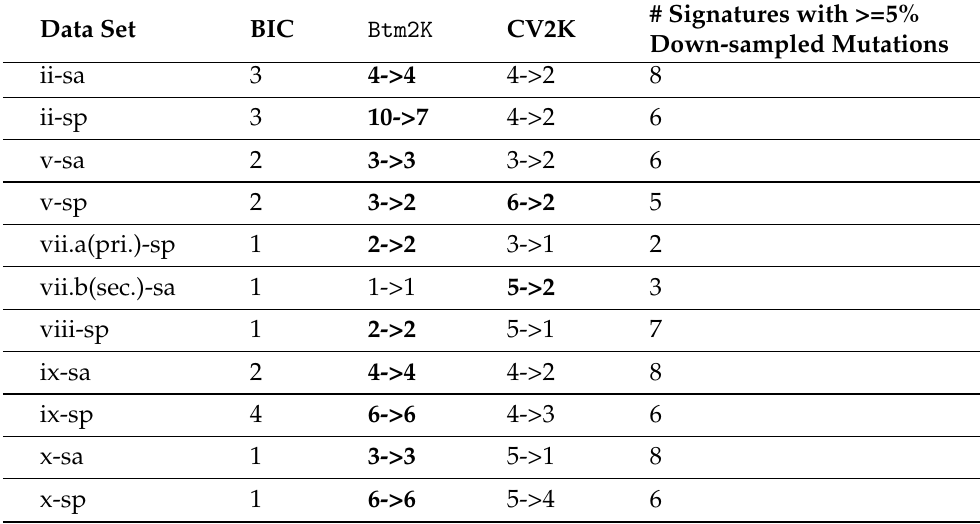
Table 3. Estimation of number of signatures in simulated data. For Btm2K and CV2K, the numbers of the best run and the numbers after rollback are shown. In the last column, the number of signatures were present in more than 5% of the mutations as an estimate for the true solution. In bold are the methods that performed best with regard to this